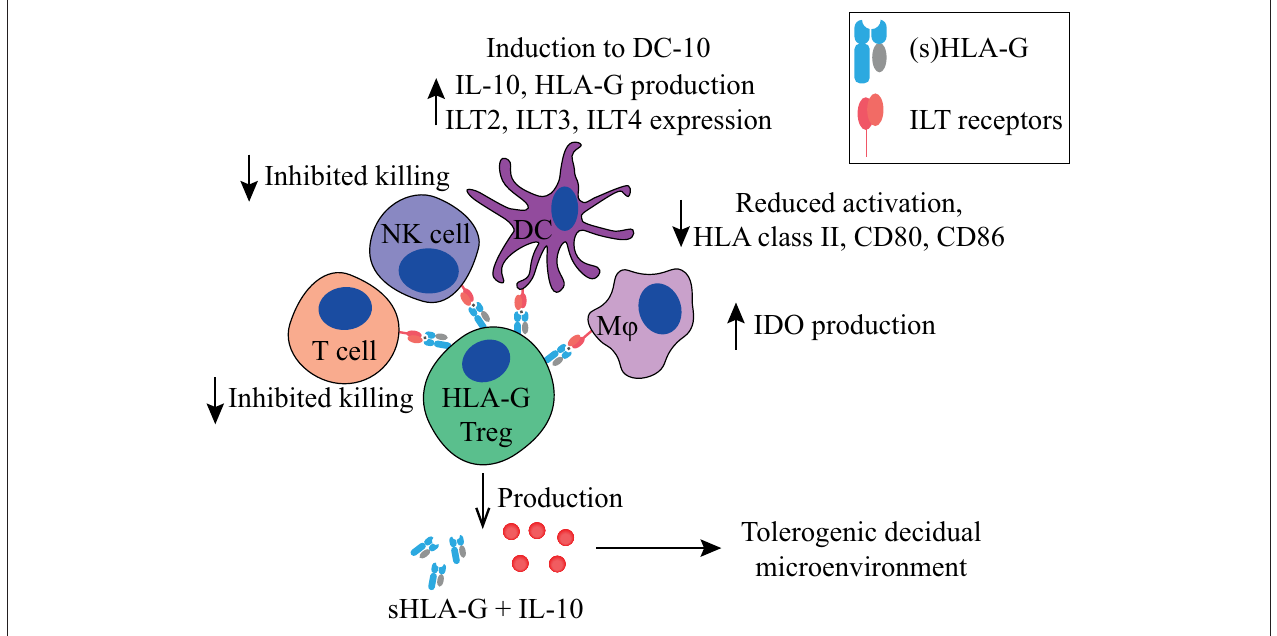
FIGURE 2 | Main tolerogenic mechanisms of the FoxP3 − HLA-G + regulatory T cell. HLA-G + regulatory T cells can suppress in a cell-contact dependent manner via HLA-G1. It inhibits the killing capacity of T cells and NK cells, downregulates HLA class II, CD80, and CD86 in DCs and macrophages, and makes them tolerogenic by inducing IDO production in macrophages and the induction of DCs to DC-10 cells. HLA-G + regulatory T cells produce IL-10 and soluble HLA-G5 that helps to create a tolerogenic decidual microenvironment. HLA, human leukocyte antigen; NK, natural killer cell; DC, dendritic cell; IDO, indoleamine 2,3-dioxygenase; IL-10, interleukin-10; DC-10, tolerogenic